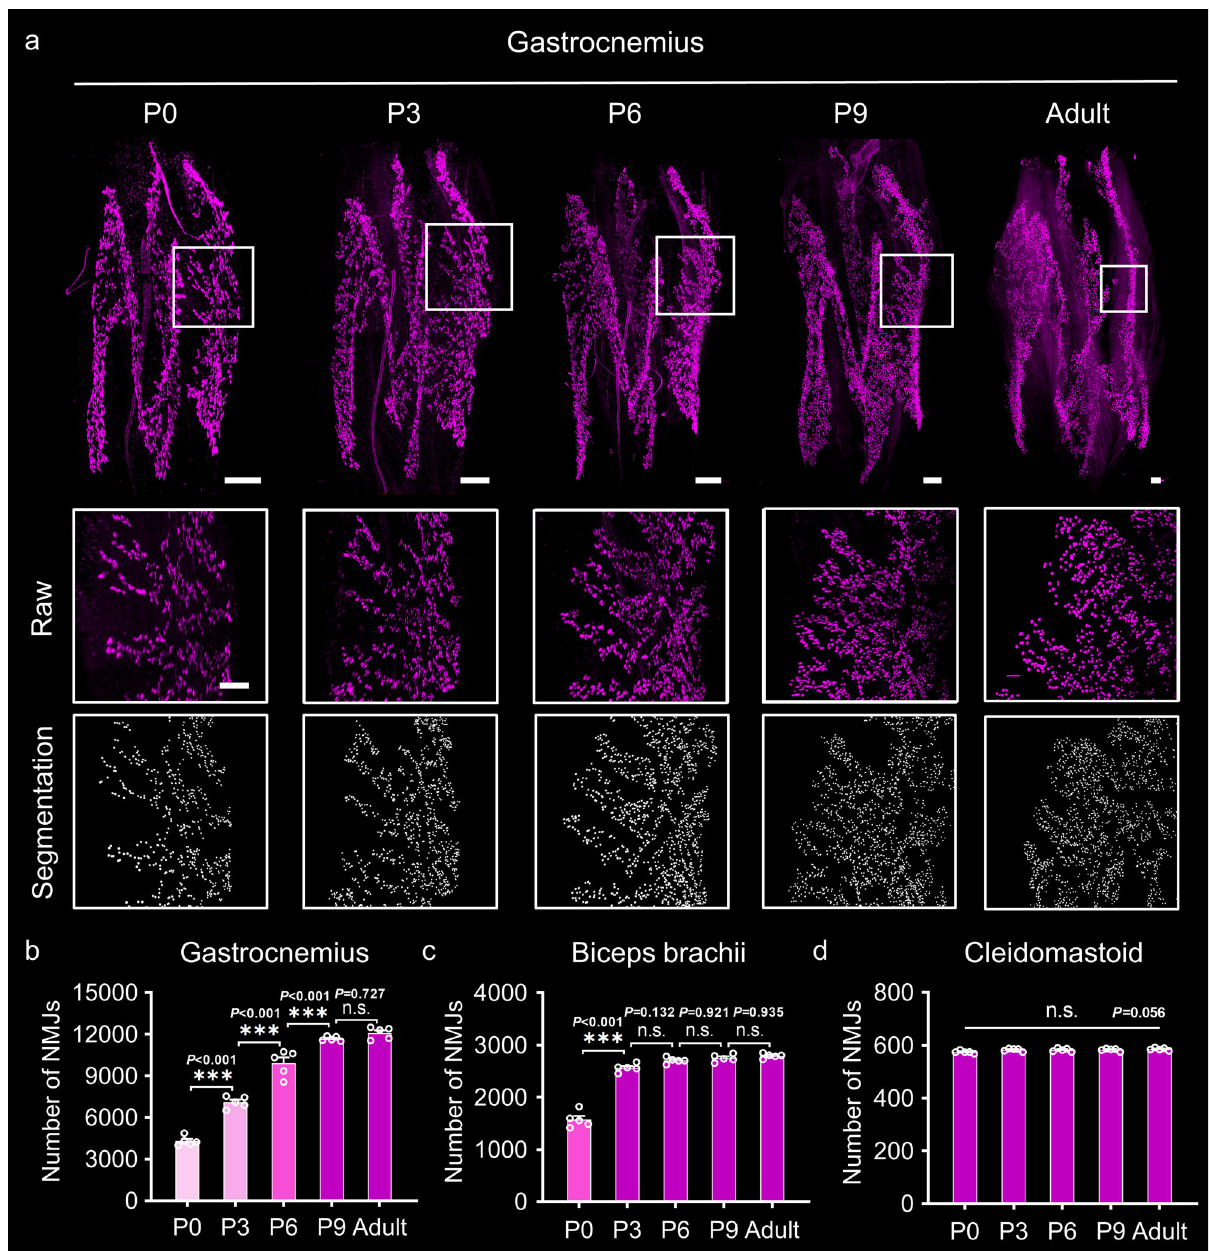
Fig. 6 3D analysis of NMJs during postnatal development. a 3D distributions of NMJs in the gastrocnemius at different time points (P0, P3, P6, P9, and adulthood); scale bar: 200 μ m. The images in the white frames are enlarged and shown in the second row; scale bar: 100 μ m. The images in the third row show the segmentation of NMJs. b – d The quanti fi cation of NMJs in the gastrocnemius ( b ), biceps brachii ( c ), and cleidomastoid ( d ) at different time points ( n = 5 independent animals for each muscle at each time point). All values are presented as the means ± SEM; statistical signi fi cance in (b-d) (n.s. represents not signi fi cant and ***P < 0.001) was assessed using one-way ANOVA followed by Tukey post hoc